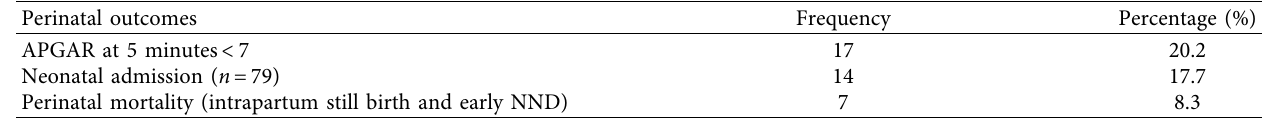
Table 4: Perinatal outcomes of vaginal breech delivery.